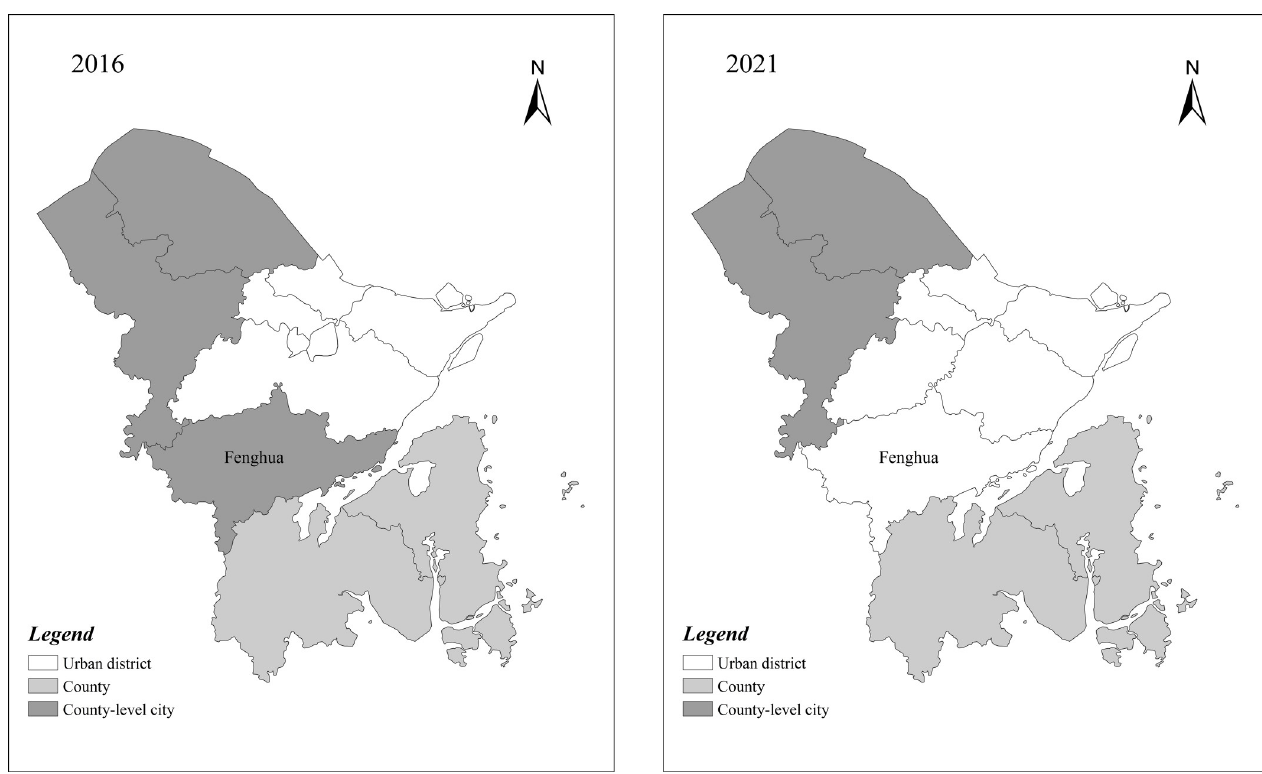
Fig 5. Comparison of administrative divisions in Ningbo, Zhejiang Province, 2016 and